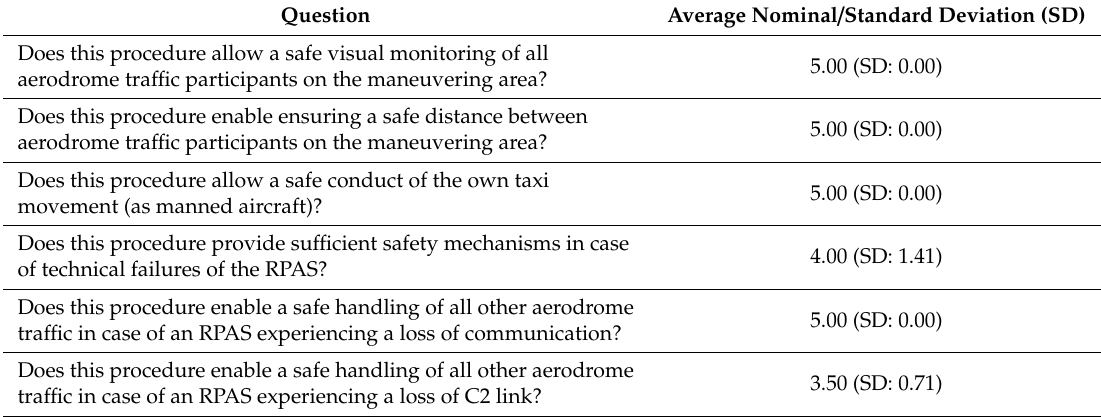
Table 4. Results of tailor-made questionnaires related to safety in non-nominal situations (loss of command and control link, and loss of communication), answered by conventional pilots.